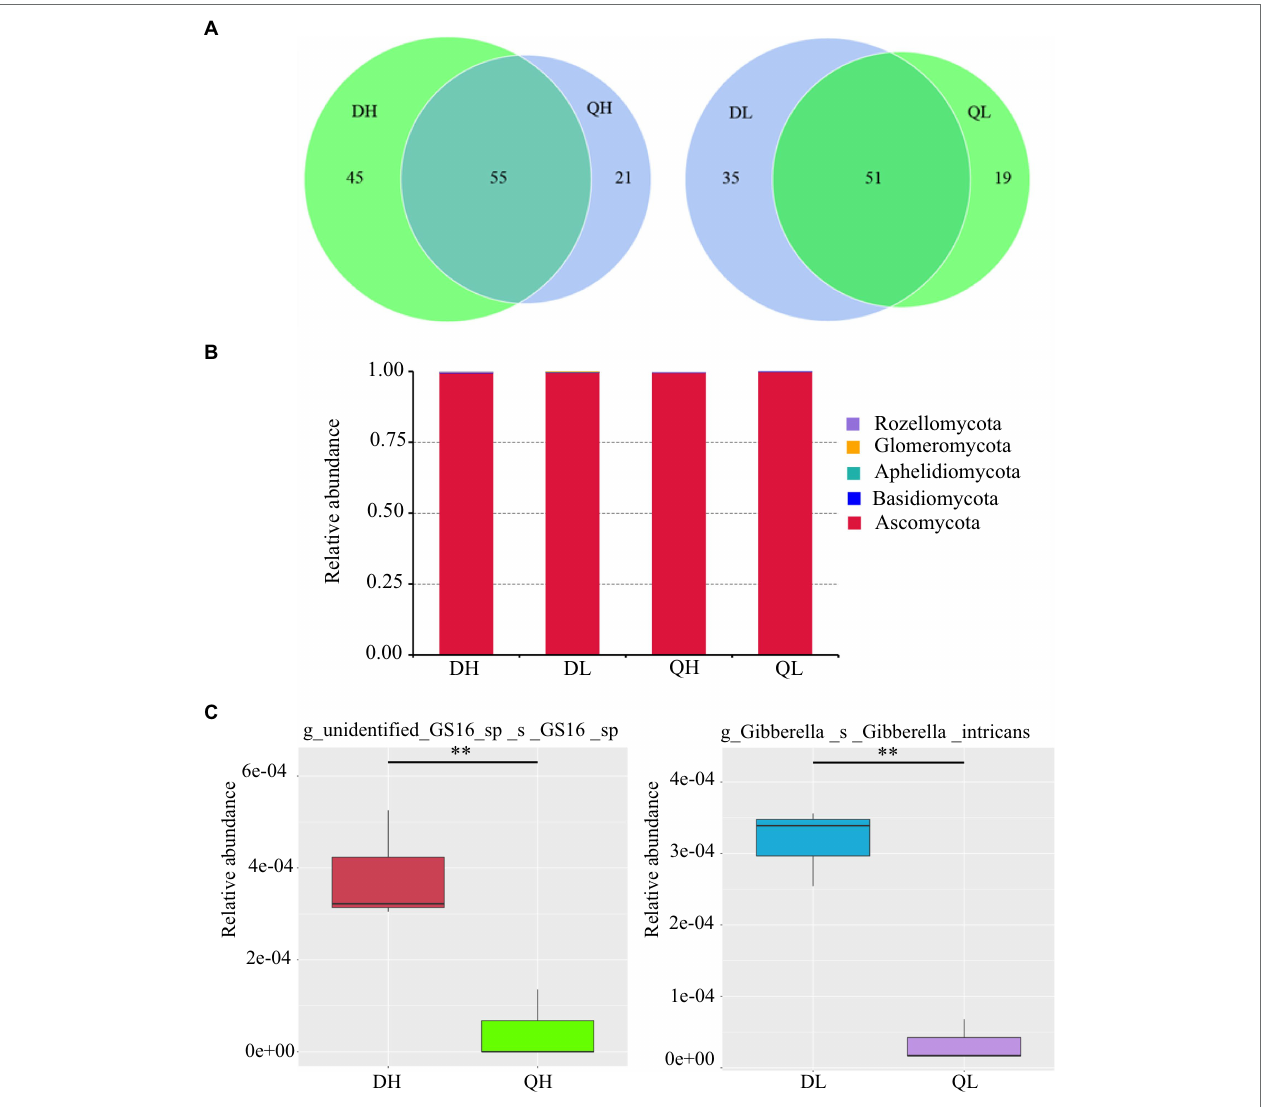
FIGURE 5 | Relative abundance of fungal taxonomic units in Du Shi and Qing Zhou Mi Tao roots grown at high and low P conditions. (A) Numbers of fungal OTUs in Du Shi and Qing Zhou Mi Tao roots. (B) Relative abundance of fungal taxa at the phylum level in Du Shi and Qing Zhou Mi Tao roots. (C) Specific taxa enriched in Du Shi and Qing Zhou Mi Tao roots under HP or LP conditions. ** p < 0.01, Student’s t